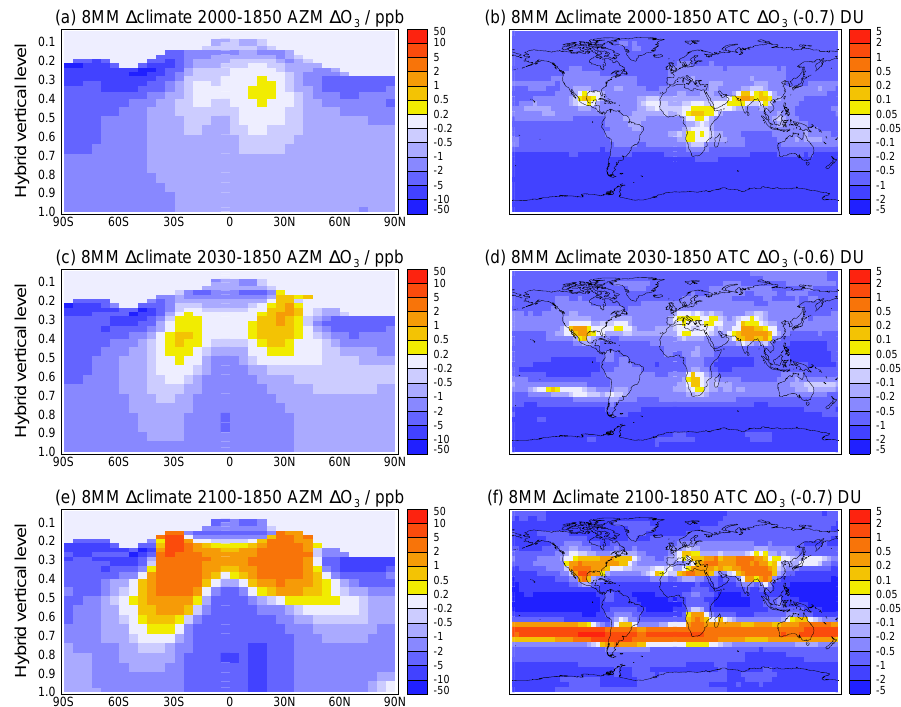
Fig. 6. Eight-model mean (8MM) responses of ozone to climate change. The eight models are A, F, G, L, M, N, O, and P. Panels (a, c, e) are AZM changes; (b, d, f) are ATC changes. Panels (a, b) show changes for 2000s–1850s climate change; (c, d) for 2030s(RCP8.5)-1850s climate change; and (e, f) for 2100s(RCP8.5)-1850s climate change. Figure S7 shows equivalent plots for individual